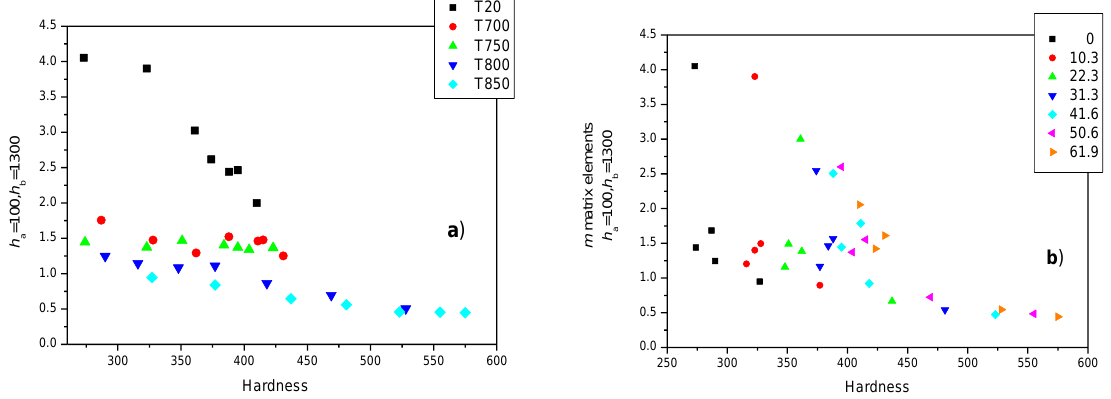
Figure 15. ( h a = 100 and h b = 1300) m matrix elements for all samples, indicating the actual heat treatments as functions of the hardness ( a ) and indicating the actual rolling reductions ( b ). However, if the other group of magnetic descriptors ( h a = 1200 and h b = 1300) are used for the magnetic characterization of the material, the correlation with the hardness is different, as shown in Figure 16. The difference in the MAT parameters vs. the hardness values is significant in the cases of deformed but unannealed samples. It is also possible to consider the saturation polarization as a function of the hardness, as shown in Figure 17. The correlation, or lack of correlation, is identical with the case of the ( h a = 1200 and h b = 1300) m matrix elements. The good correlation between ( h a = 100 and h b = 1300) m matrix elements are demon- strated better, if—for illustration—the two groups of samples are considered separately. This is illustrated in Figure 18, where the MAT descriptors are shown for cold-rolled but unannealed samples (Figure 18a) and for cold-rolled samples annealed at a temperature of 800 ◦ C (Figure 18b). The regression factors of the linear fit are also indicated in the